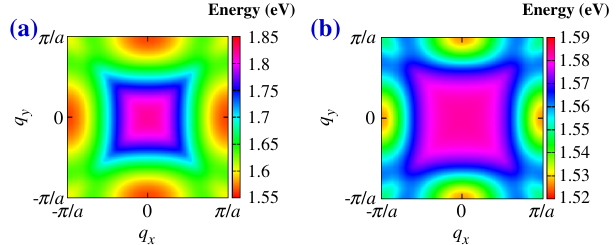
FIG. 2. Dispersion of confined photonic and polaritonic bands in 2D wave-vector space. (a) Dispersion of the lowest confined photonic band in the first Brillouin zone − π lattice constant is a ¼ 365 nm. (b) Dispersion of the lower polariton branch in the same wave-vector region. The QW width is 4 nm. The lower band edge (1.56 eV) of guided 2D modes within the 3D PBG is 30 meV below the exciton-recombination ¼ 1 . 59 eV). The exciton-photon coupling of 48 meV energy ( E X 0 involves the collective response of 100